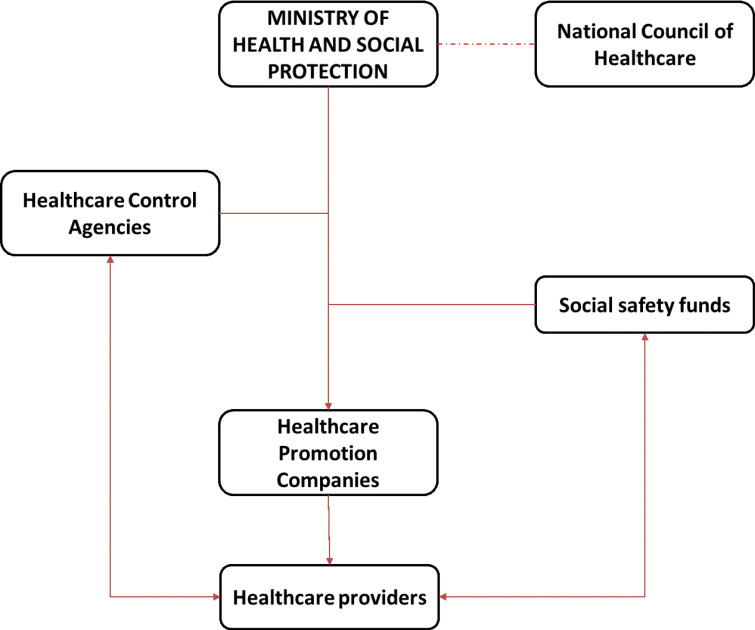
Configuration of healthcare system.